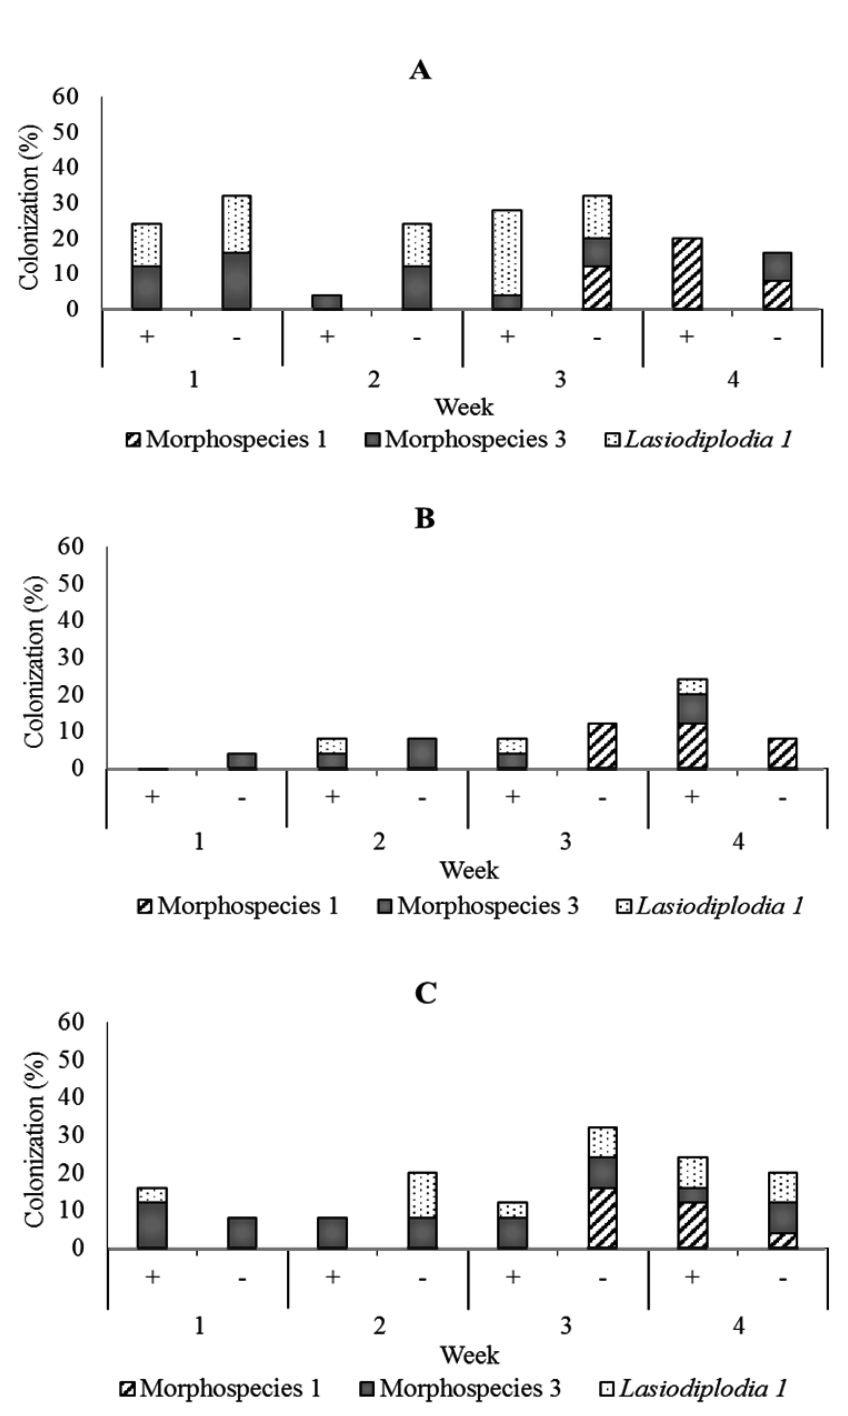
Fig. 5. Dominant fungal endophytes colonizing leaf (A), stem (B) and root tissues (C) of four-month-old seedling at one, two, three, and four weeks after Trichoderma asperellum inoculation through stem infusion. +, with T. asperellum ; -, without T.